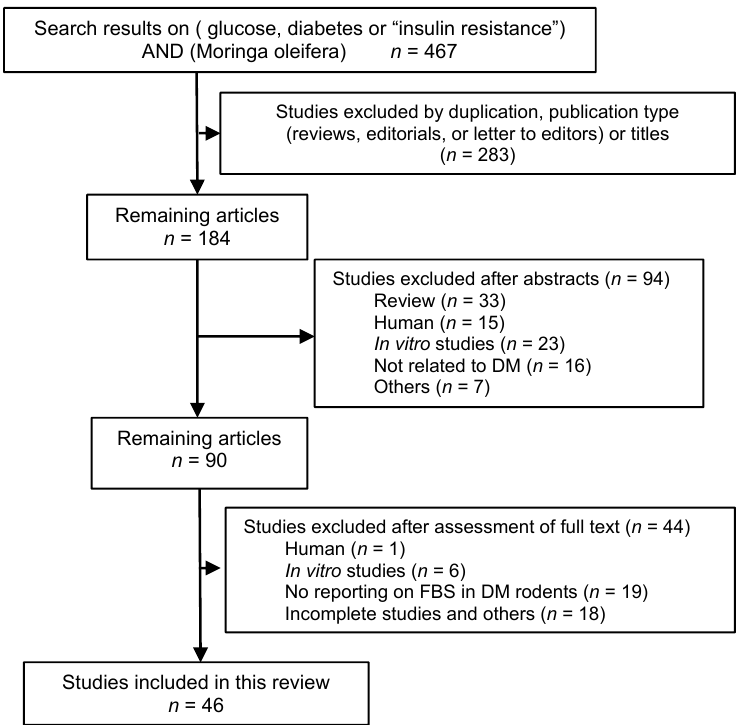
Figure 1. Flow diagram of literature search and selection process.